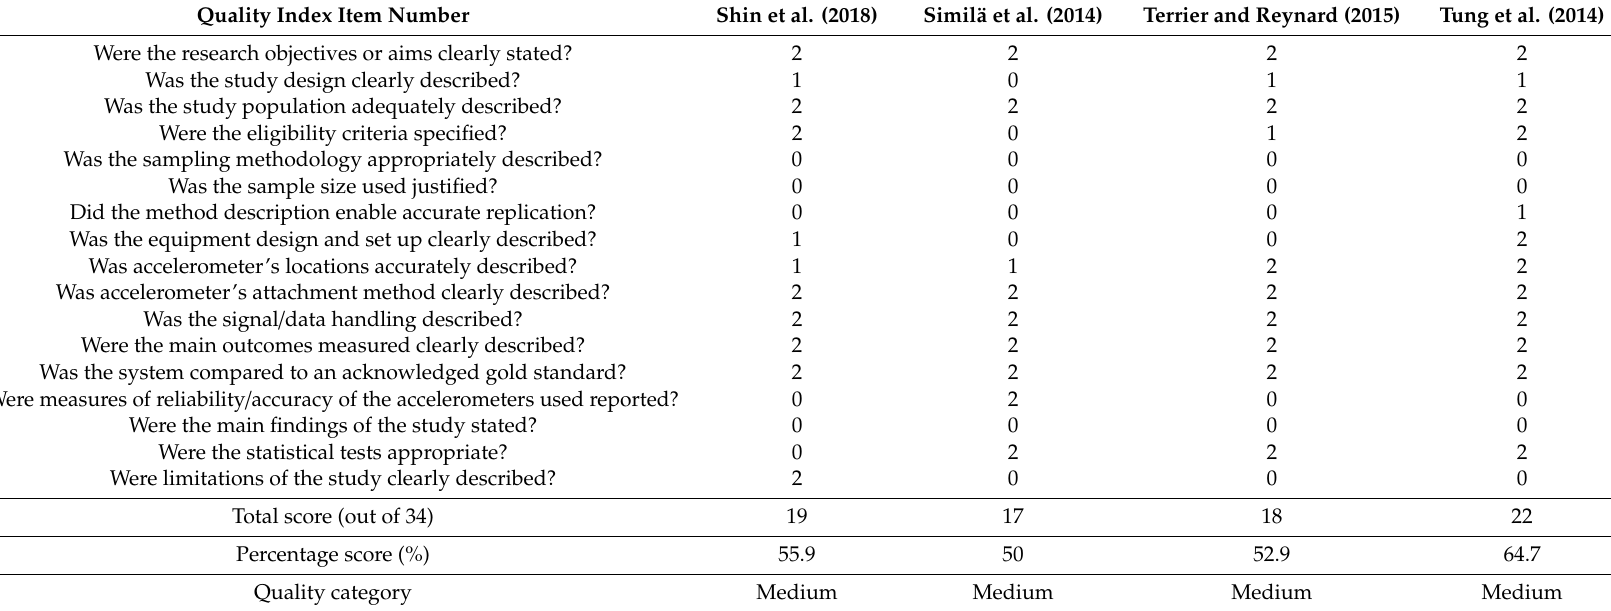
Table A3. Quality assessment of included